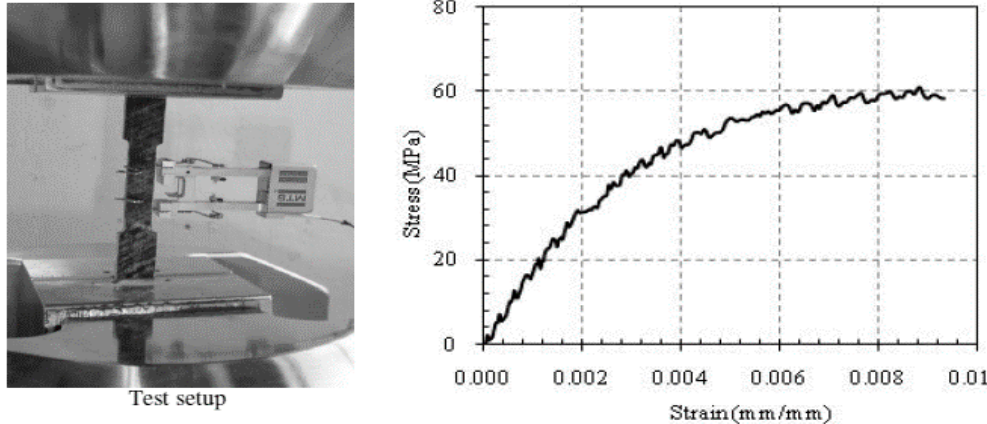
Figure 5. Test setup and stress-strain curve for the FRP tubes for coupon tensile test of Tube B [28].